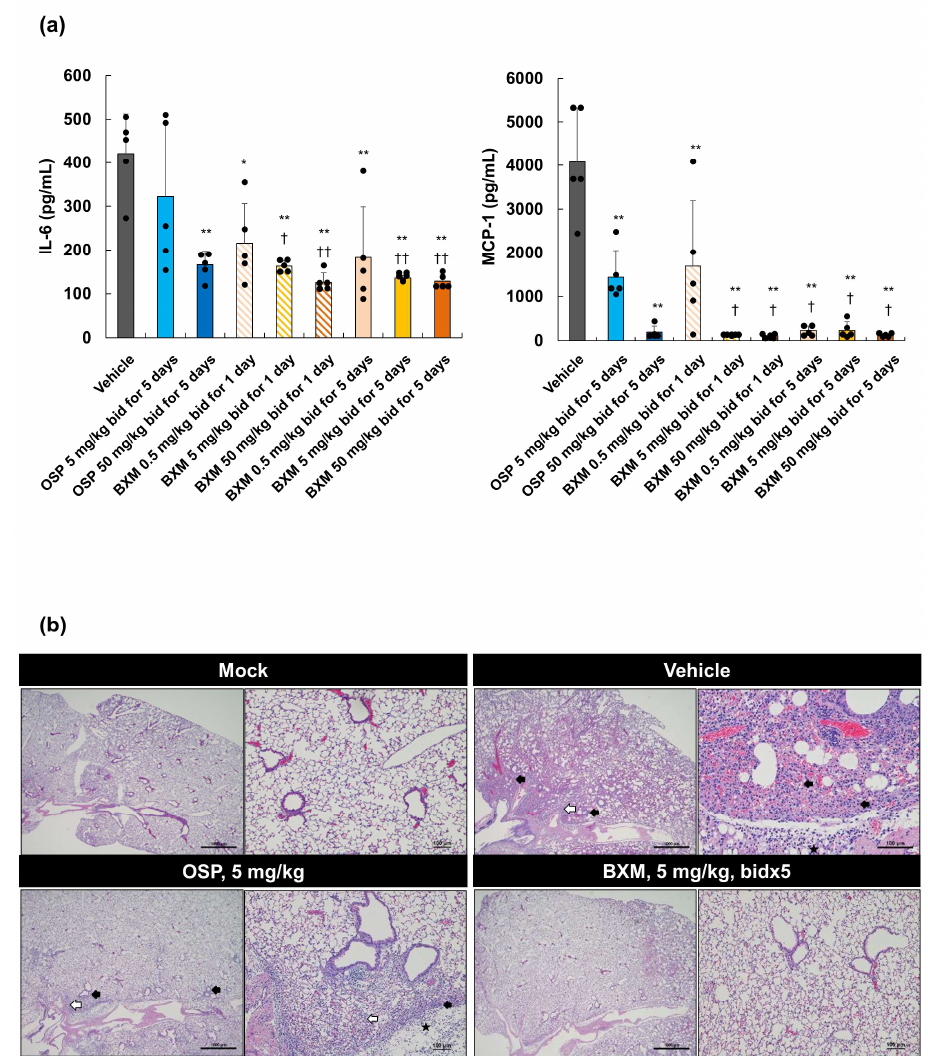
Figure 3. Prevention of inflammation in the lungs of mice infected with H5N1 viruses follow- ing BXM treatment. The mice were intranasally infected with 75 TCID 50 /mouse (31.3 MLD 50 ) of A/Hong Kong/483/1997 (H5N1) virus, and treatment was started immediately after viral inoculation ( n = 5/group). ( a ) interleukin (IL)-6 and monocyte chemoattractant protein (MCP)-1 production in the lungs at 5 dpi was then quantified. Dunnett’s multiple-comparison method was conducted for the statistical comparison of IL-6 and MCP-1 production between each group (* p < 0.01, ** p < 0.001 compared with the vehicle. † p <0.05, †† p <0.01 compared with OSP at 5 mg/kg twice daily). ( b ) The lungs after each dosing were collected and fixed in a perfusion, containing 10% phosphate-buffered formalin. The formalin-fixed left lungs were then dissected, embedded in paraffin, and sectioned. Hematoxylin and eosin-stained sections, which were prepared for specimen and histopathological analyses, were subsequently analyzed. The left panels of each dosing represent wide fields (2 × magnification of objective), whereas the right panels of each dosing represent narrow fields (20 × magnification of objective). The black arrows indicate the thickening and inflammatory cell infiltration of alveolar walls. The white arrows indicate inflammatory cell infiltration within the alveoli. The black stars indicate edema. Mock: the mice were inoculated with Dulbecco’s phosphate-buffered saline and administered vehicle (0.5 w / v % methylcellulose) twice daily for 5 days.